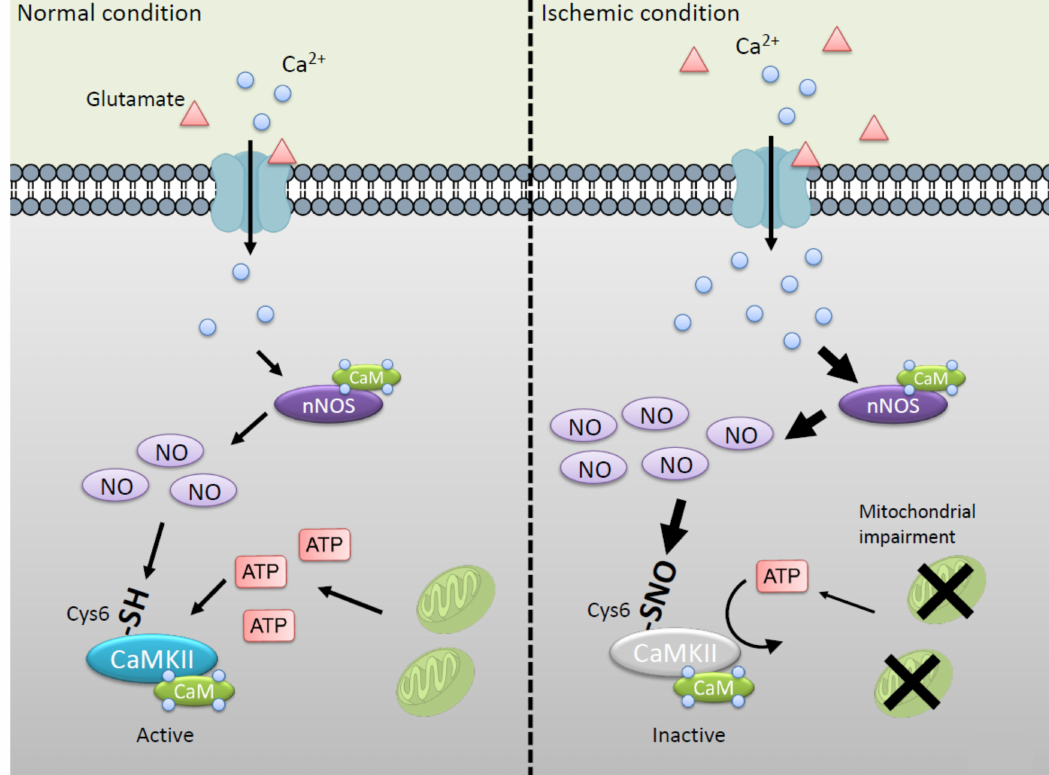
Figure 4. Inactivation of CaMKII via S -nitrosylation at Cys6 in the ischemic condition. In the normal condition (left panel), CaMKII and nNOS are controlled by glutamate signaling via NMDAR. Note that high levels of glutamate in the extracellular space are well known to occur early in the onset of ischemia, leading to the enhanced Ca 2 + entry and the neuronal injury (right panel) [70]. At the same time, intracellular ATP concentration is decreased by mitochondrial impairment [67]. NO inhibits CaMKII activity via S- nitrosylation at Cys6 with ATP competitive fashion. S -nitrosylated CaMKII tends to be inhibited under the condition of low ATP concentration. This figure is an image of the postsynaptic hippocampal neuron where the mutual regulation of nNOS and CaMKII mainly